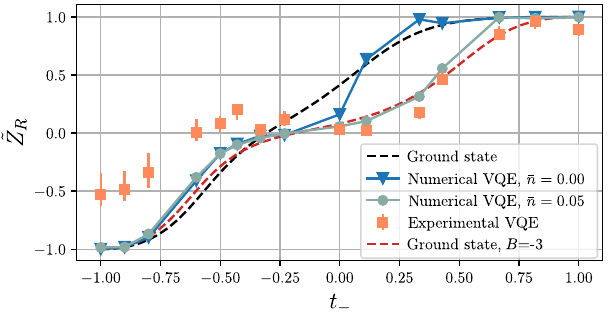
˜ Z FIG. 8. Partial reflection MBTI R , Eq. (7), for the extended SSH model, Eq. (B1), at δ ¼ 4 with N ¼ 8 and n ¼ 4 . The dashed lines give the MBTIs from the exact ground states. In black we show the ground state without a pinned magnetic field B ¼ 0 , while red depicts the case with B ¼ − 3 ; see the text. Numerical simulations of the VQE with the c.m. mode having a mean phonon number ¯ n ¼ 0 and ¯ n ¼ 0 . 05 are shown by the solid lines. The experimentally measured data are represented by squares.